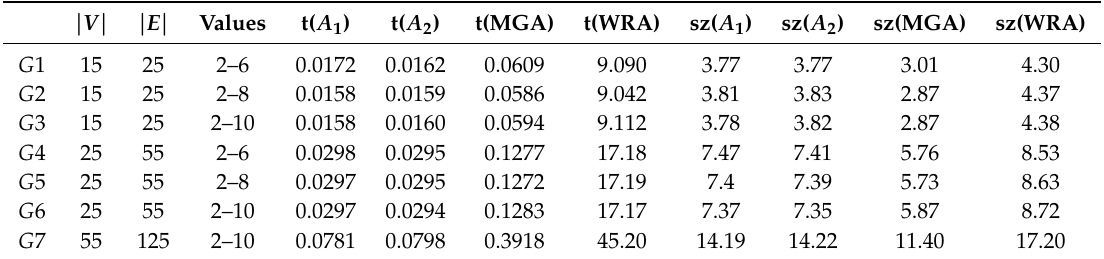
Table 1. The random graphs generated by different parameters and the results of four